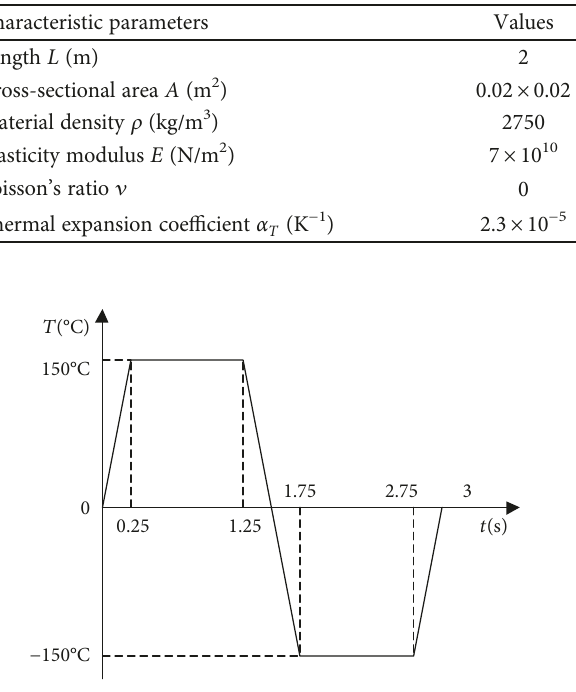
Figure 5: The linear array deployable structure with three SLEs. Table 2: Material properties and geometry sizes of the deployable structure.